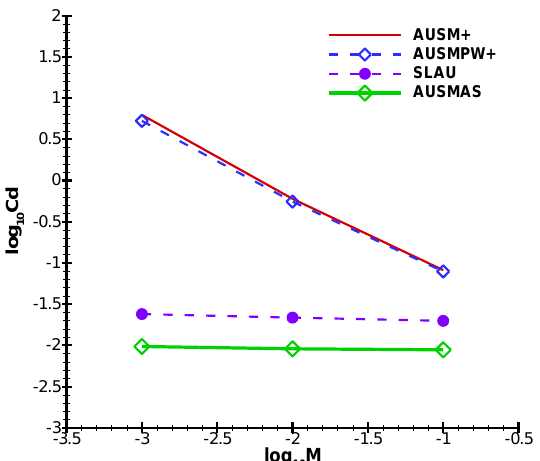
Figure 15. Drag coefficients vs inflow Mach number (first order reconstruction, dense grid).